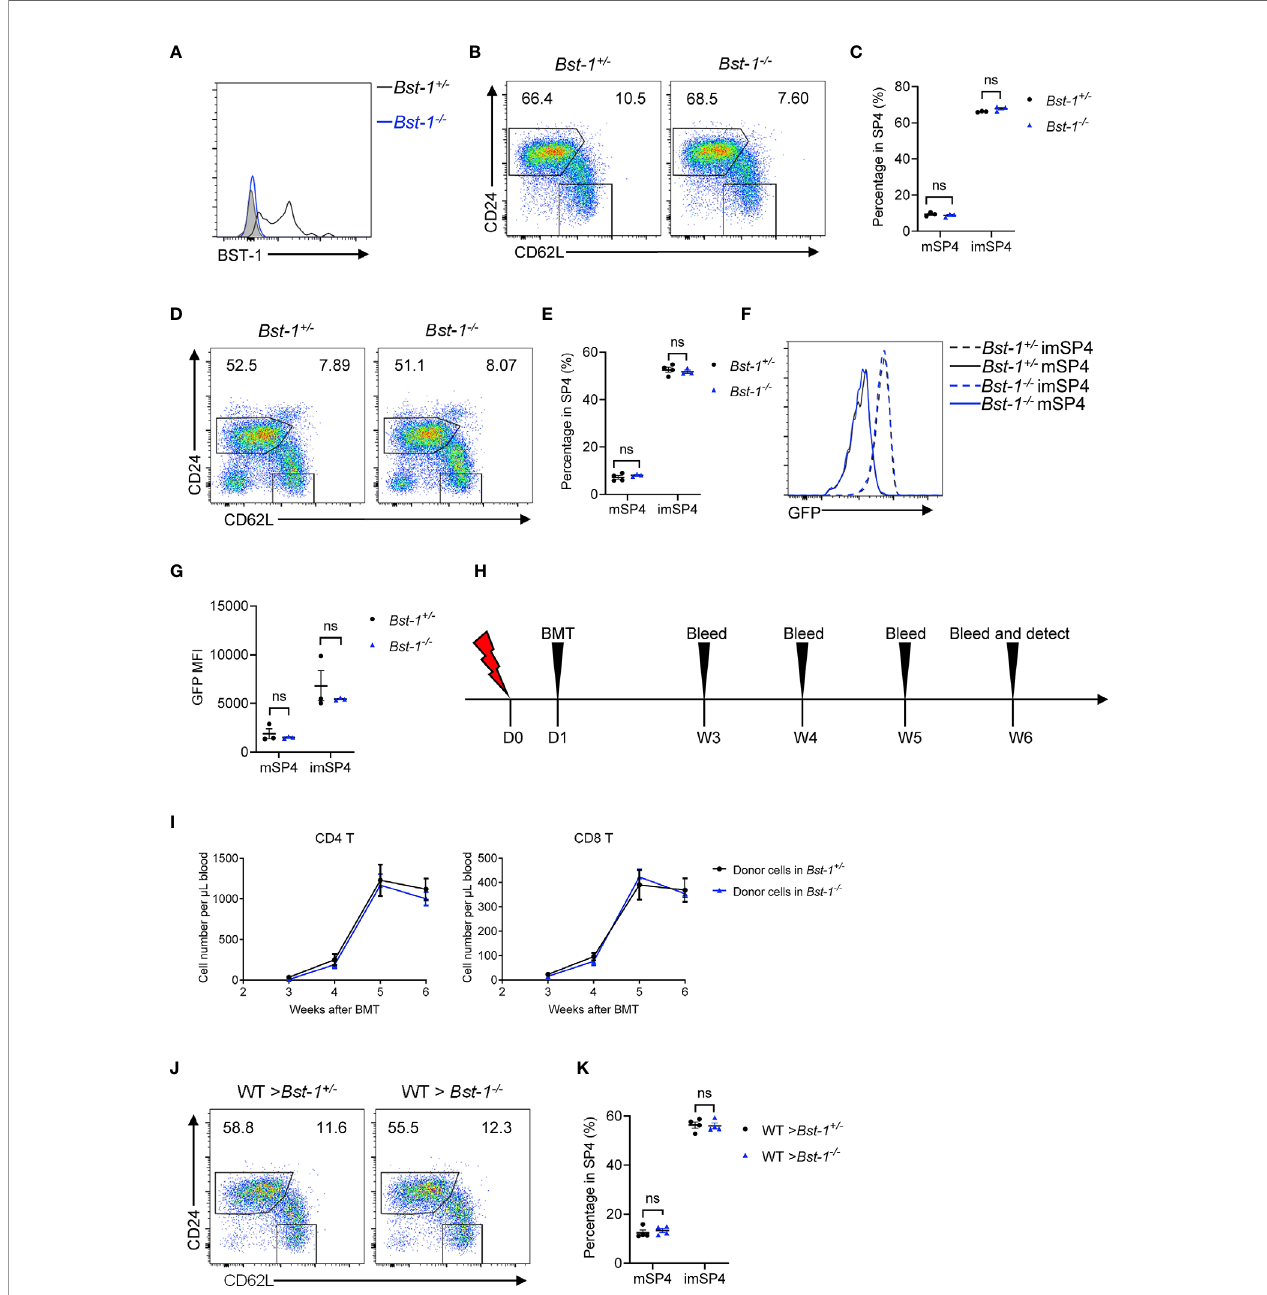
FIGURE 8 | BST-1 does not regulate thymic egress. (A) Flow cytometric analysis of BST-1 expression on thymic TPECs (CD45 − CD31 + Ly6C − P-selectin + ) in Bst-1 − / −